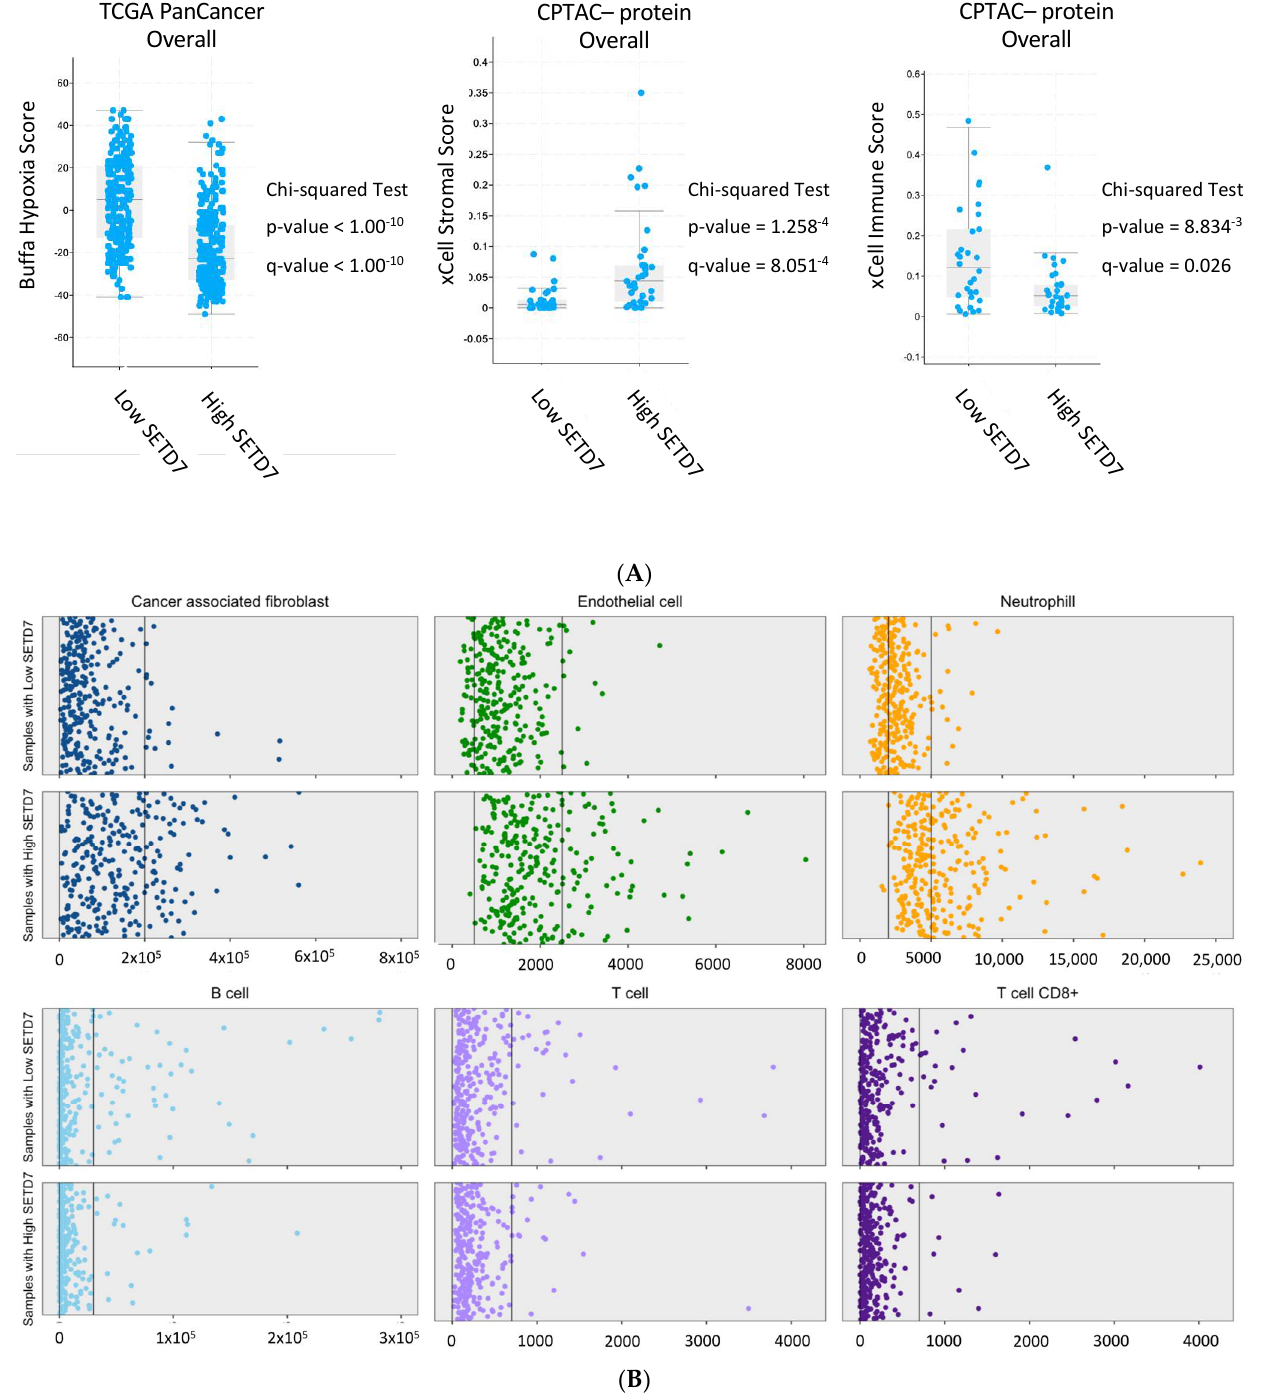
Figure 2. Correlation of SETD7 differential expression with clinical factors. ( A ) Association of SETD7 differential expression (high vs. low) with Buffa Hypoxia Score (mRNA), xCell Stromal Score and xCell Immune Score (protein) when pooling all breast cancer types together. Wilcoxon test p -value and Benjamini–Hochberg FDR correction q -value; ( B ) Association of SETD7 differential expression (high vs. low) with tissue-infiltrating immune and stromal cell populations using mcp_count method [48] from immunodeconv package and TCGA-BRCA data overall.